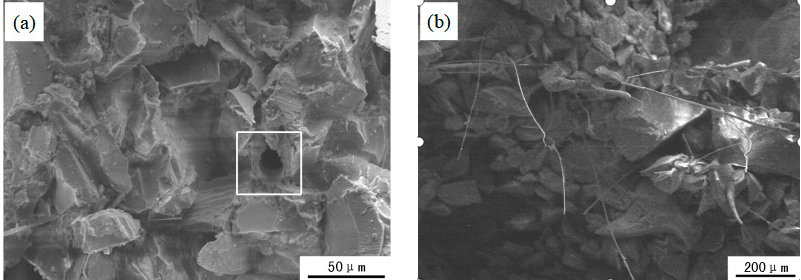
Figure 7. SEM image of fracture surface of investment casting shell after roasting: ( a ) nylon-fiber enhanced-shell; ( b ) ceramic enhanced-shell.